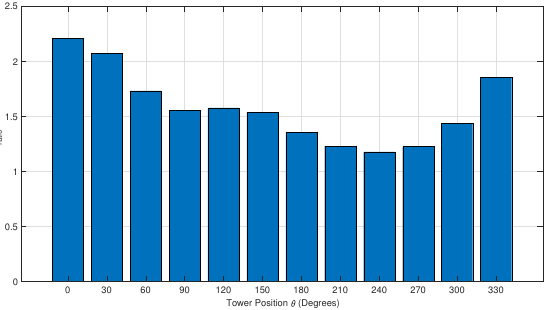
Figure 21. Absolute D Ratio between uni-directional fatigue damage and fatigue damage at a range of tower positions θ for wind rose 1 with the application of the Goodman’s correction